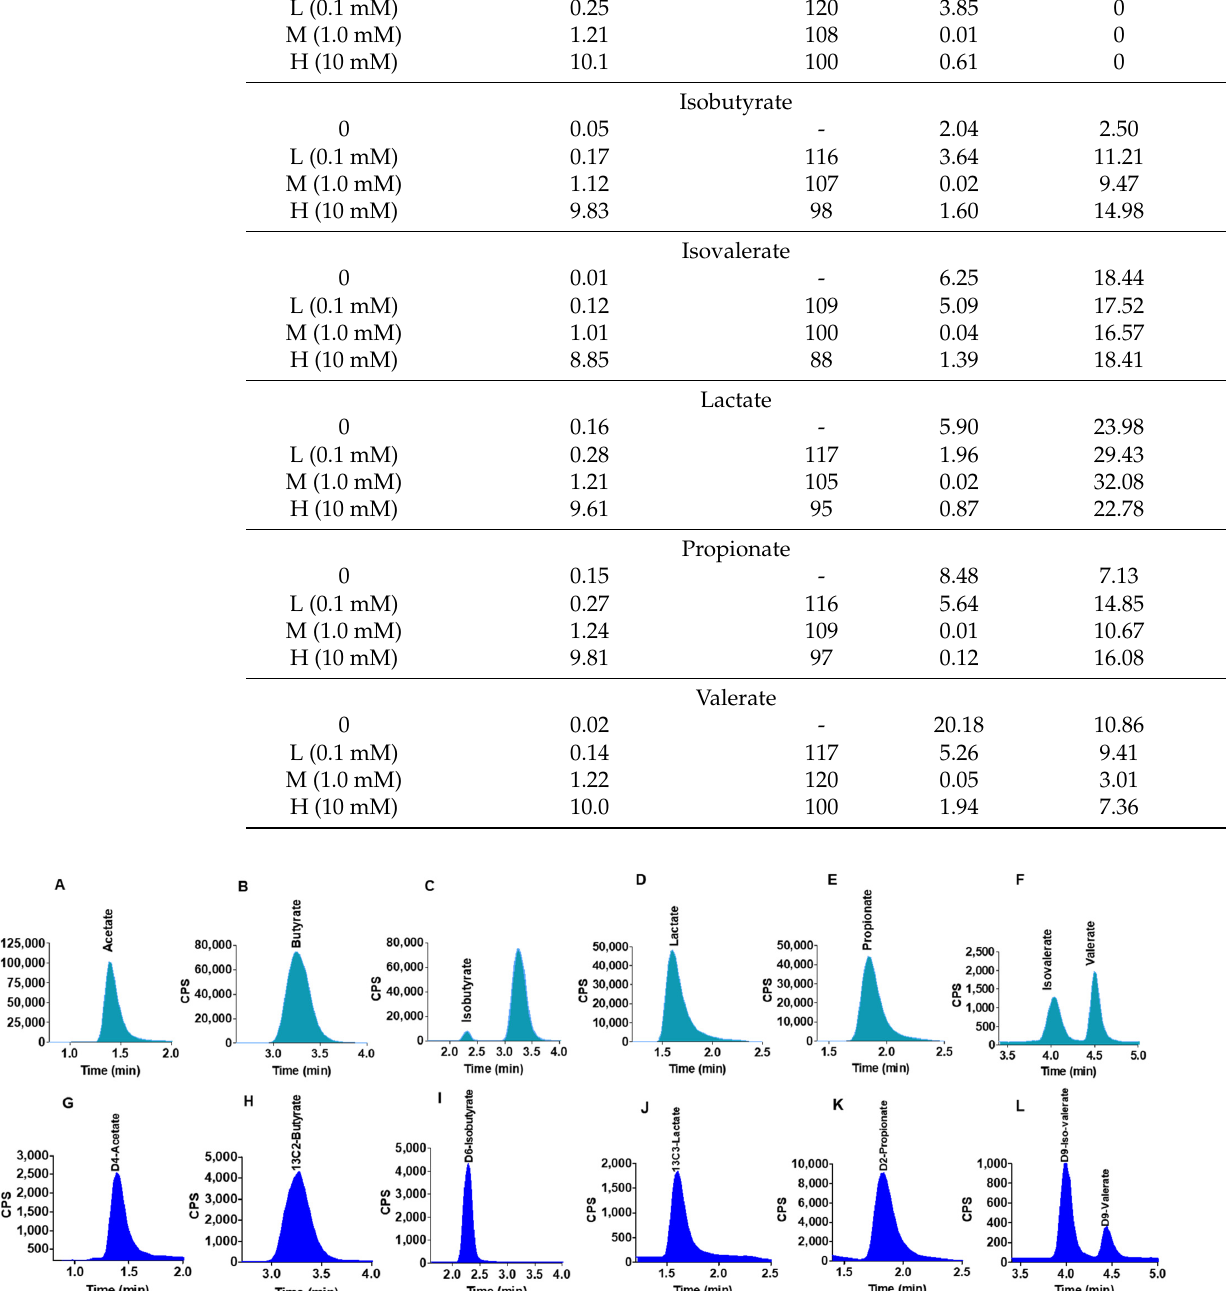
Figure 2. LC-MS generated SCFA peaks in colon model fermentation samples. ( A – F ) peaks detected in colon model fermentation samples. ( G – L ) corresponding labelled internal standards of SCFA in colon model samples.